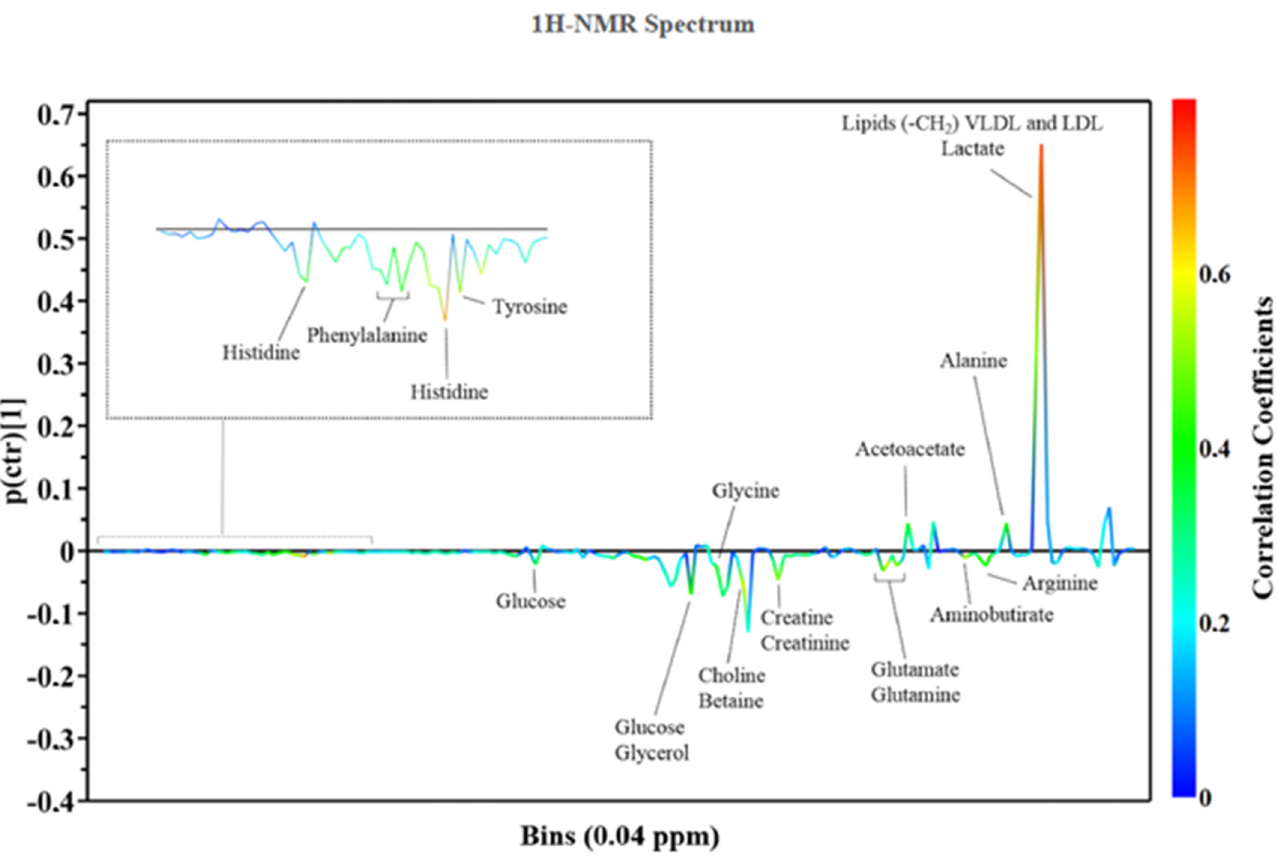
Figure 1. Metabolic pattern from 1H-NMR Spectrum. Central illustration. The continuum of the development of cardiotoxicity due to anticancer therapies and the potential application of metabolomics to its investigation and diagnosis .